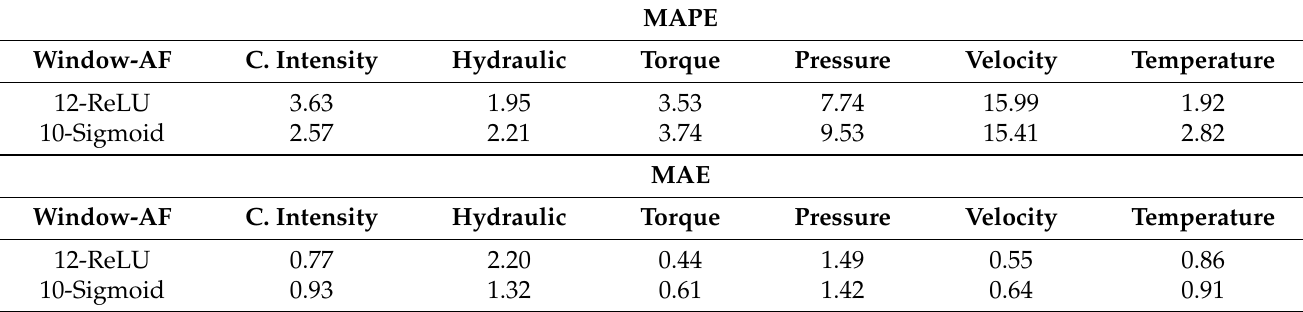
Table 2. Summary of the best prediction errors obtained with the GRU models. Window is the historical window size in days. AF is the output activation